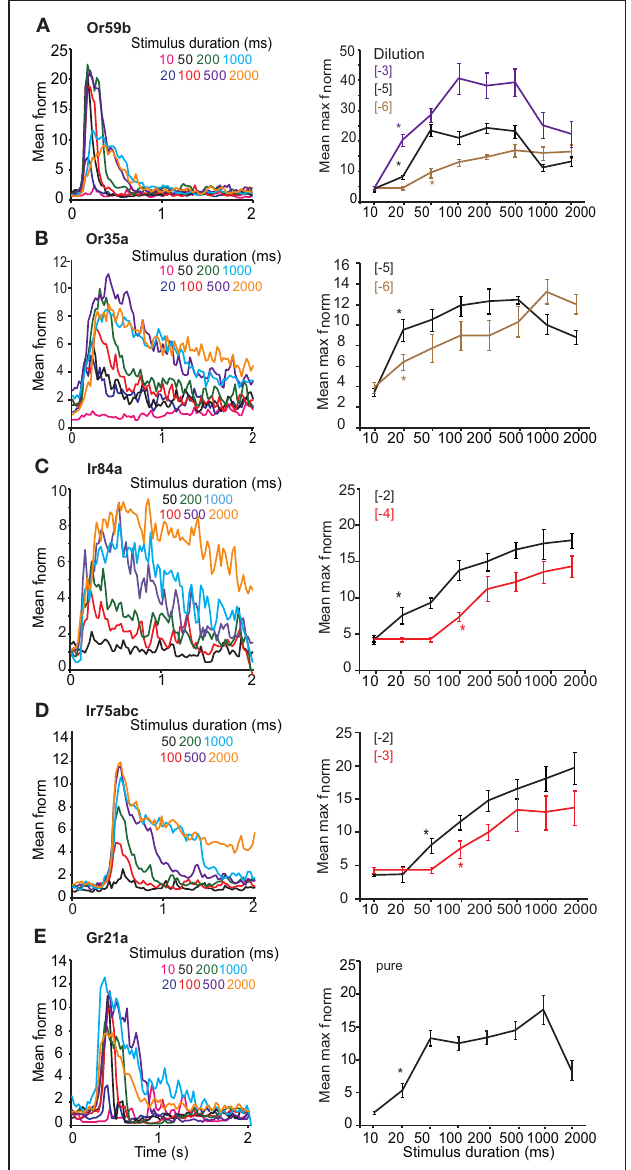
FIGURE 2 | Response of OSNs to varying stimulus durations. ( A , left) Mean peri-stimulus time histograms (PSTHs, 25ms bins) showing the response of Or59b-expressing OSNs to various stimulus durations of log [ − 5] v/v methyl acetate. ( A , right) Mean normalized maximum frequency for Or59b-expressing neurons plotted vs. stimulus duration ( n = 8–15) for three different concentrations. Asterisks indicate the minimum stimulus duration that elicited a significant response, P < 0 . 05. ( B , left) Mean peri-stimulus time histograms as in (A) showing the response of Or35a-expressing OSNs to various stimulus durations of log [ − 5] v/v 1-hexanol. ( B , right) Mean normalized maximum frequency for Or35a-expressing neurons plotted versus stimulus duration for log [ − 5] and [ − 6] v/v of 1-hexanol ( n = 6–14). ( C , left) Response of Ir84a-expressing neurons to various durations of log [ − 4] v/v phenyl acetaldehyde as in (A) , n = 8–10 ( C , right) as in A for two different concentrations. ( D , left) Response of Ir75abc-expressing neurons to various durations of log [ − 3] v/v butyric acid ( n = 6–15) and (D , right) as in (C) . (E) Response of Gr21a-expressing neurons to pure CO 2 at different stimulus durations ( n = 6–10).